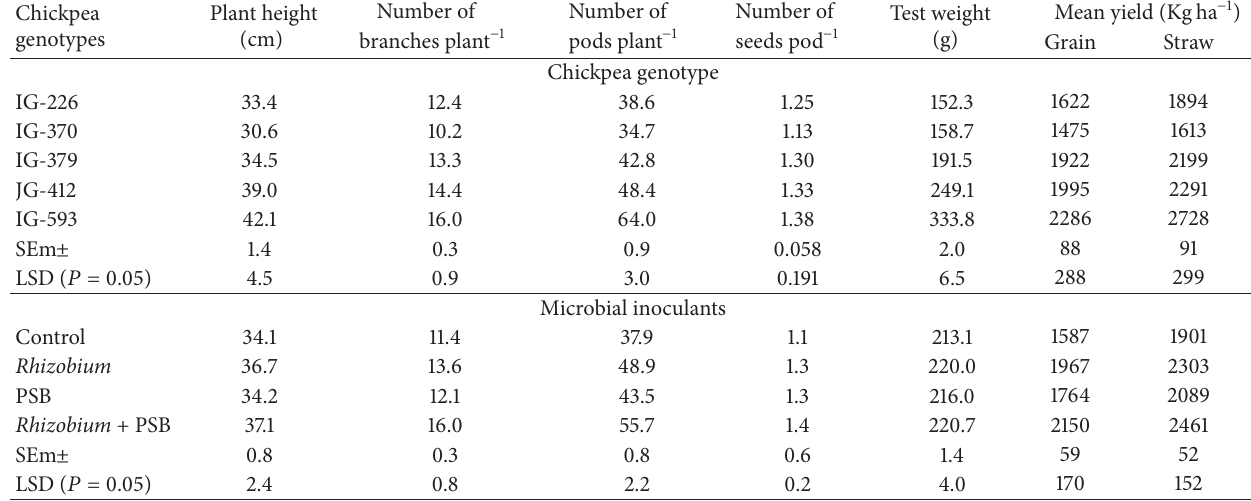
Table 3: Yield attributes, grain and straw yields of chickpea genotypes.